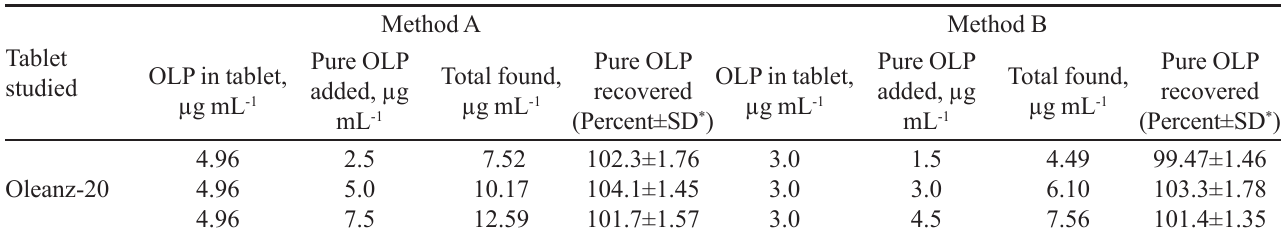
TABLE VI - Results of recovery study via standard-addition method